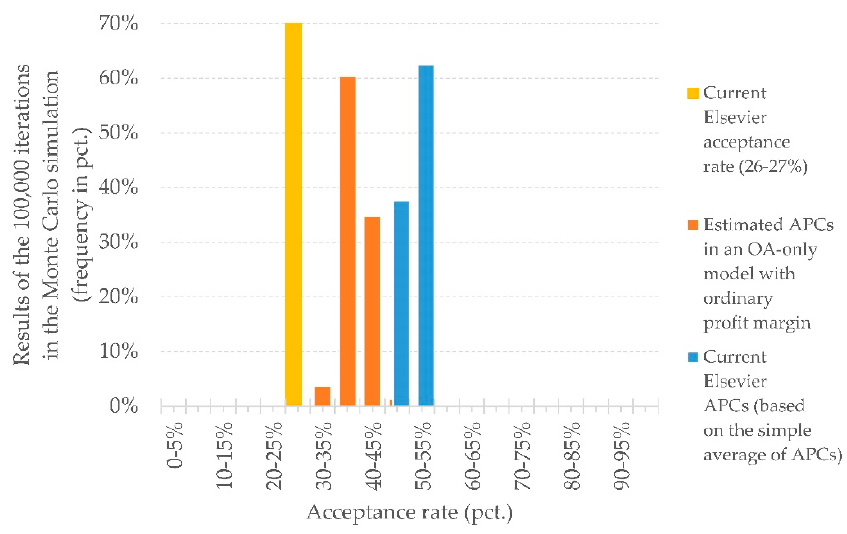
Figure 3. Results: potential acceptance rates with current Elsevier APCs in comparison to acceptance rates with estimated average APCs in an OA-only model and an ordinary profit margin (based on 2017 data).